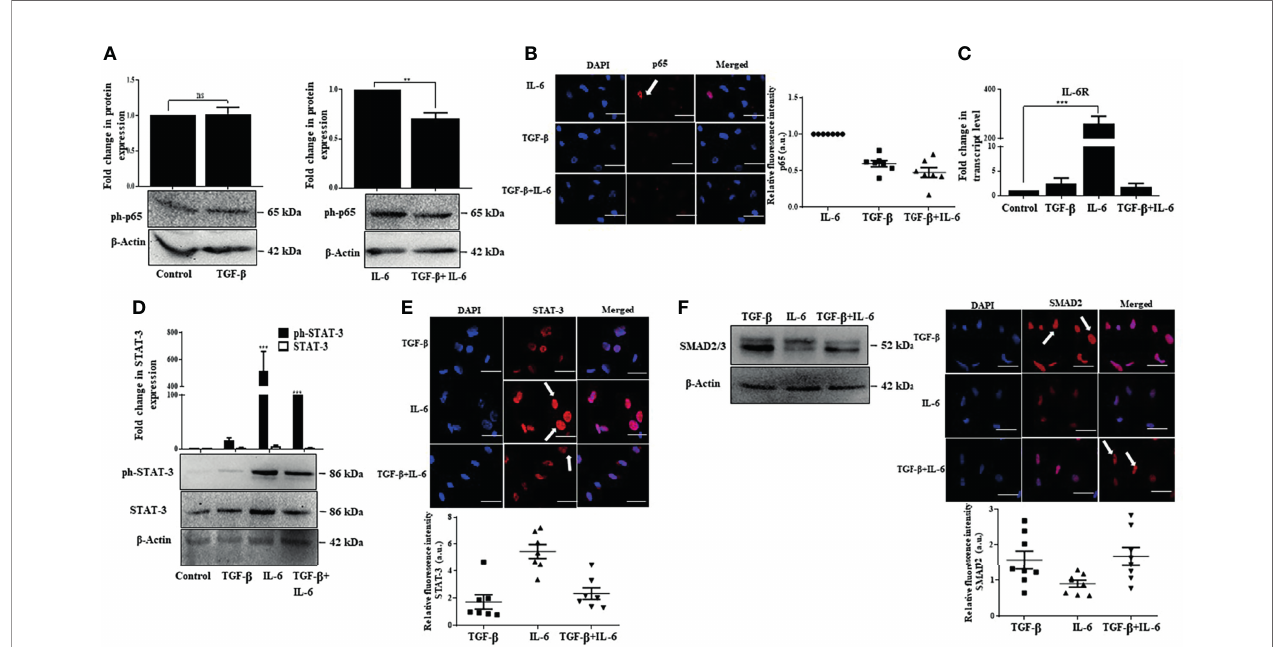
FIGURE 7 | IL-6-induced effects are suppressed by TGF- b through inhibition of p65 and STAT-3. (A) Immunoblot showing expression of phosphorylated p65 after TGF- b /IL-6 or TGF- b plus IL-6 treatment for 72 h. (B) Immuno fl uorescence image and relative fl uorescence intensity of p65 in TGF- b /IL-6 or TGF- b plus IL-6 treated cells (scale bar: 10 m m). White arrow indicates p65 protein. (C) Transcript levels of IL-6R after TGF- b /IL-6 or TGF- b plus IL-6 treatment for 72 h. (D) Immunoblot showing expression of STAT-3 in TGF- b /IL-6 or TGF- b plus IL-6 treated cells after 72 h of exposure. (E) Immuno fl uorescence image and relative fl uorescence intensity of STAT-3 in TGF- b /IL-6 or TGF- b plus IL-6 treated cells (scale bar: 10 m m) White arrow indicates STAT-3 protein. (F) Immunoblot showing expression of SMAD2/3 after TGF- b /IL-6 or TGF- b plus IL-6 treatment for 72 h; immuno fl uorescence image and relative fl uorescence intensity of SMAD2 in TGF- b /IL-6 or TGF- b plus IL-6 treated cells (scale bar: 10 m m). The white arrow indicates SMAD2 protein. **, *** and ns refers to p value signi fi cance of ≤ 0.01, ≤ 0.001 & not signi fi cant